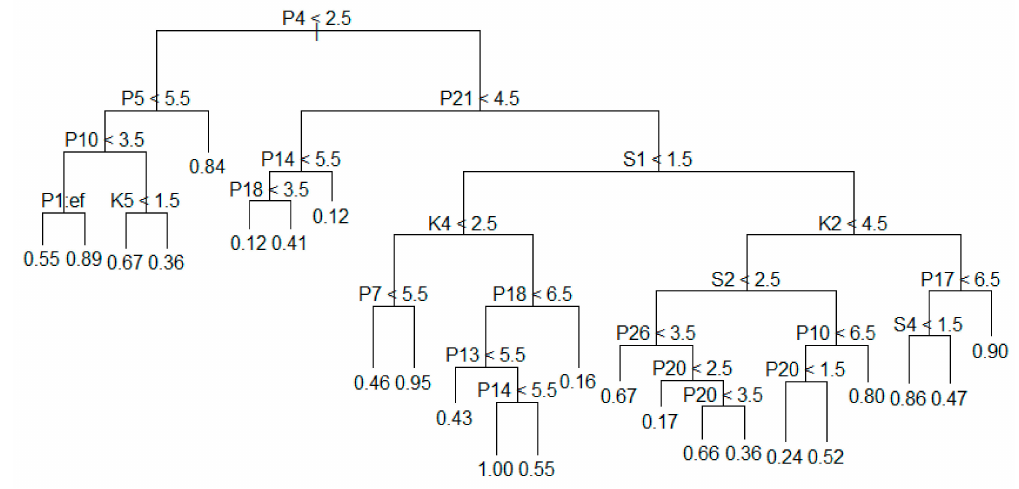
Figure 2. Loyalty classification tree in the value-oriented perspective. Source: author’s